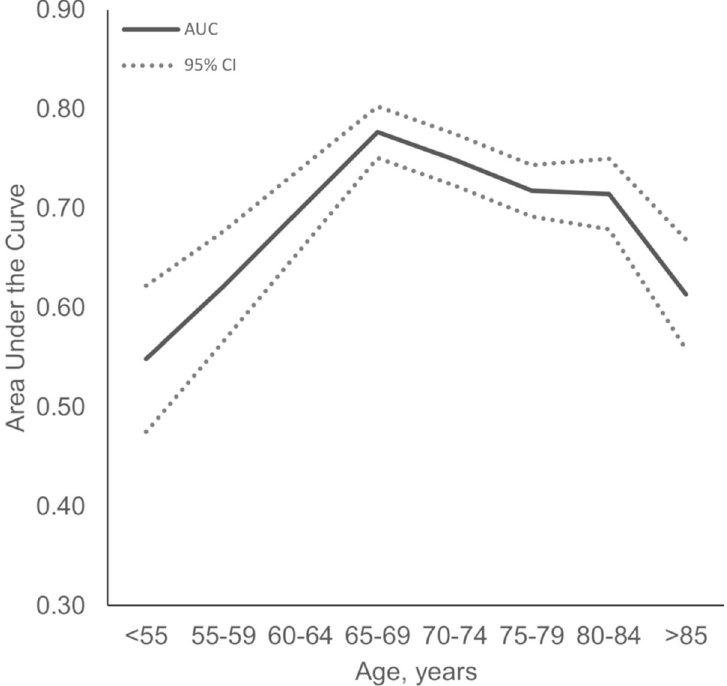
Fig 5. Analysis of the AUC in function of age for at least one APOE ε 4 carrying versus none to discriminate CSF AD from population controls. AD, Alzheimer disease; APOE , apolipoprotein E; AUC, area under receiver operating characteristic curve; CI, confidence interval; CSF, cerebrospinal